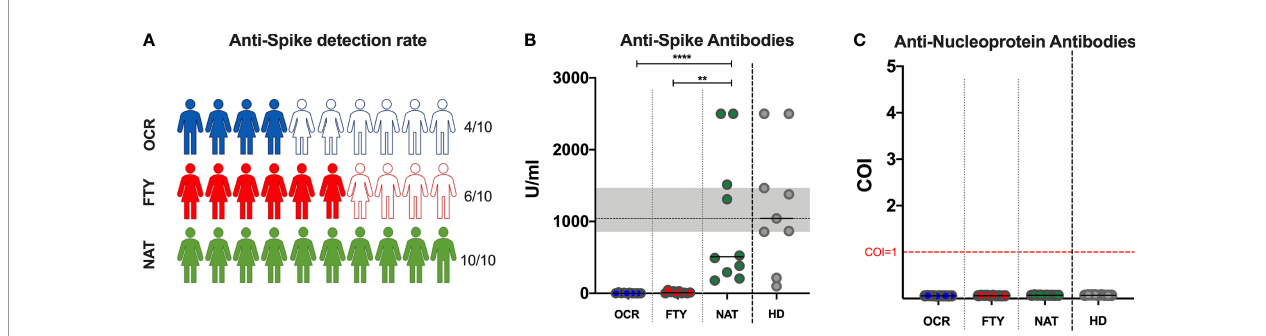
FIGURE 1 | Detection of SARS-CoV-2 anti-Spike and anti-Nucleoprotein in PwMS and healthy donors. Speci fi c SARS-CoV-2 anti-Spike detection rate (A) and titers (B) , and anti-Nucleoprotein (C) antibody detection in PwMS receiving ocrelizumab (OCR), fi ngolimod (FTY) and natalizumab (NAT). (A) . Color fi lled icons represent PwMS with anti-Spike titers above 0,8 U/ml, which was considered the positivity threshold. The differences among the three groups were assessed using the Kruskal-Wallis test, and the Dunn ’ s multiple comparison post-test, after correction for multiple comparisons. The level of statistical signi fi cance is reported. (B) . Horizontal continuous segments represent medians. Horizontal dotted black line and the gray area represent the median value and the interquartile range [IQR] observed in 9 healthy donors age and sex matched with PwMS. (C) . Horizontal dotted red line represents the cut-off value index (COI)=1, to discriminate positive from negative results. All the enrolled PwMS were negative for the detection of anti-Nucleoprotein antibodies. PwMS, people with multiple sclerosis; OCR, ocrelizumab group (blue); FYT, fi ngolimod group (red); NAT, natalizumab group (green); HD, healthy donors (gray). ** 0,01<p< 0,001; ****